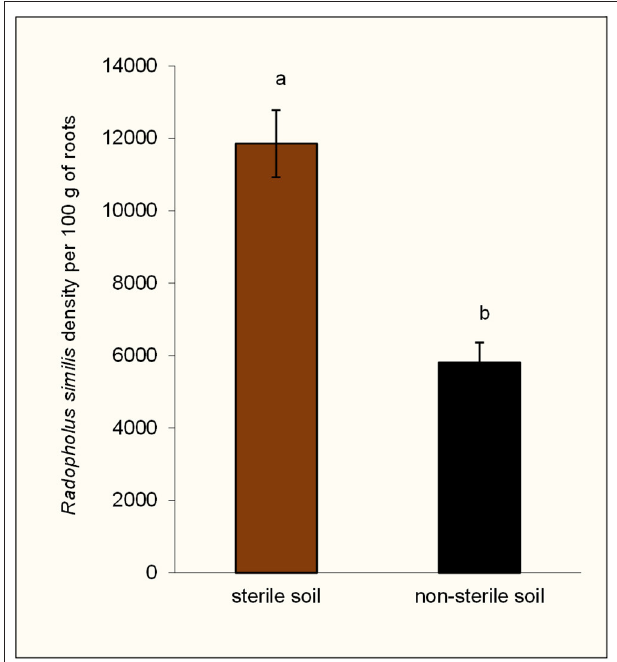
FIGURE 2 | Density of Radopholus similis in the rhizospheres of potted tissue culture banana plants grown in non-sterile soil and sterile soil after 100 days of inoculation with the nematode. Bars with the same letter represent values that are not statistically different (df